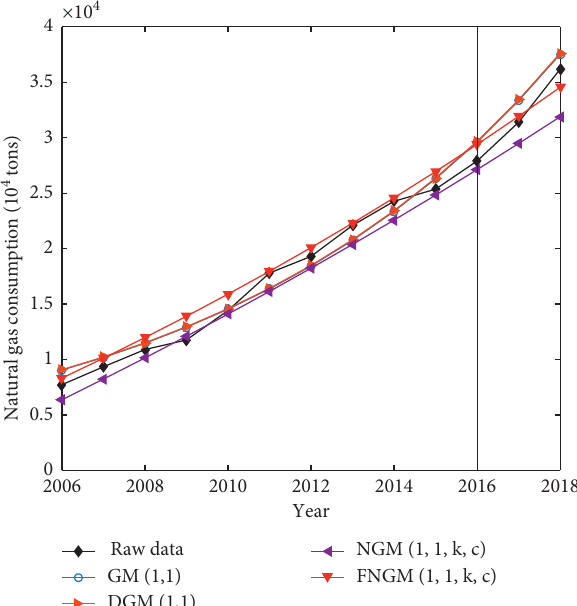
Figure 1: Curves of raw data and simulative data using these four models.